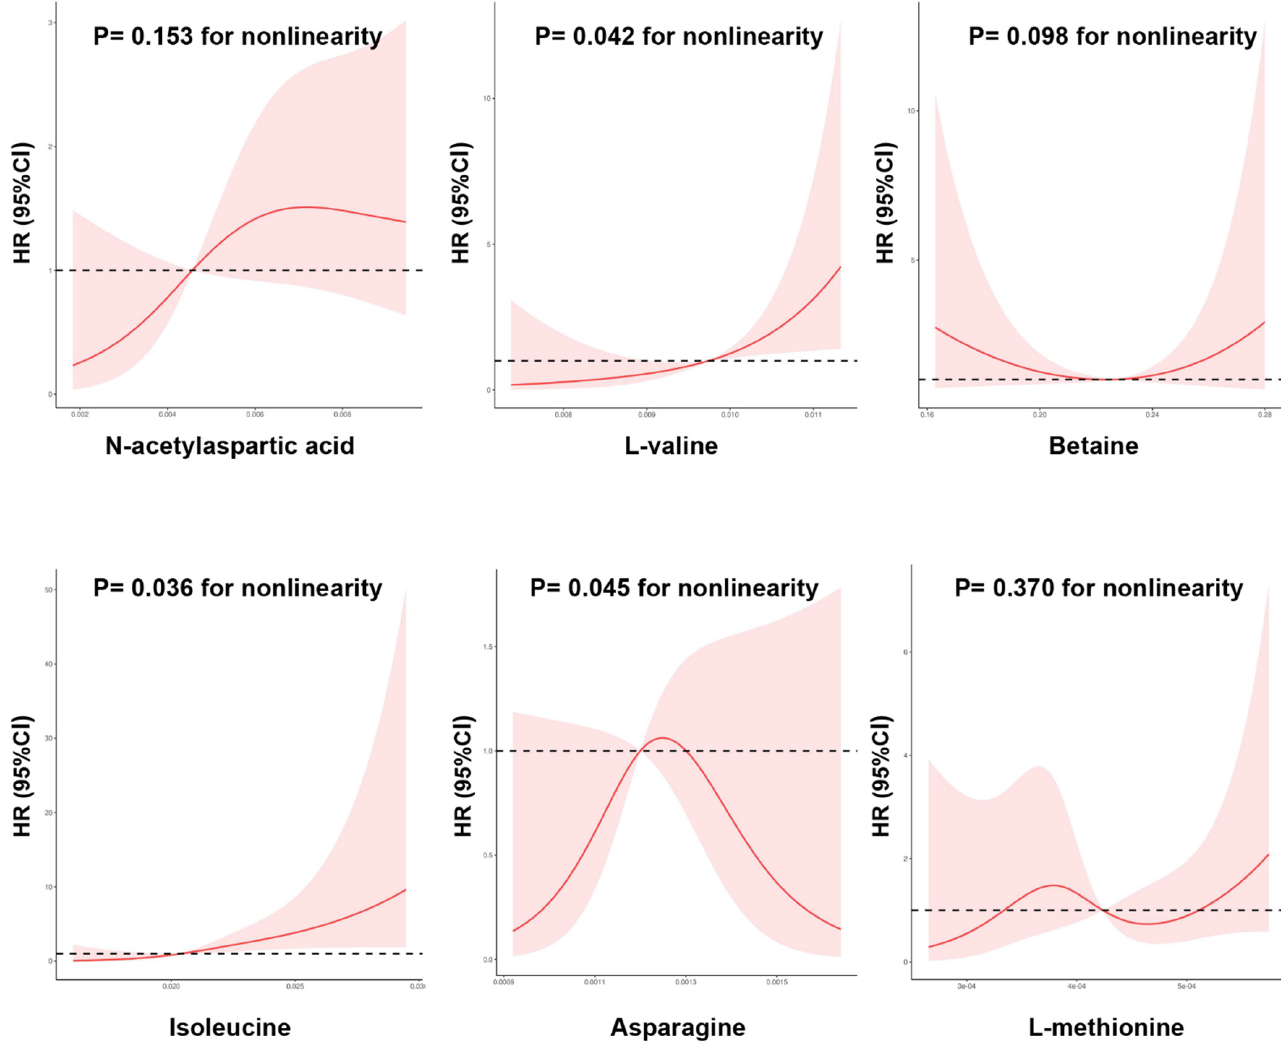
Figure 5. The nonlinear dose-dependent relationship between metabolic alterations and risk of new-onset diabetic kidney disease. Restricted cubic spline curve was carried out with 4 knots of baseline metabolic index. The solid line represents the association of metabolic index with DKD risk, and the shaded portion represents 95% CI estimation.